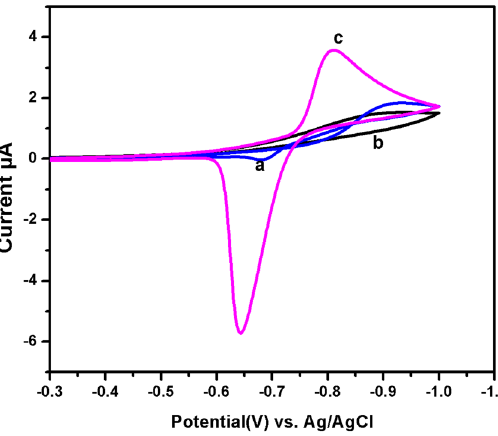
Figure 6. CV response of bare GCE in the presence of Cd (II) (a) MnCo 2 O 4 /GCE (c) and in the absence of